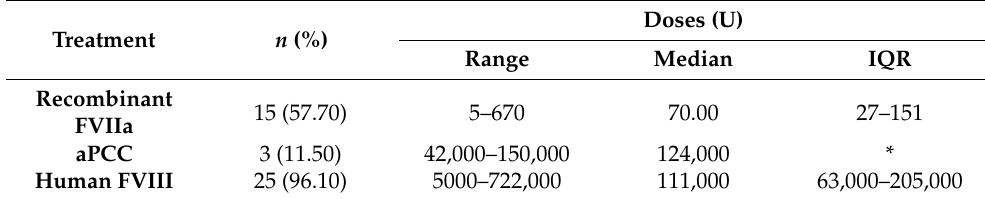
Table 4. Haemostatic treatments. Treatment n (%) Recombinant FVIIa 15 (57.70)